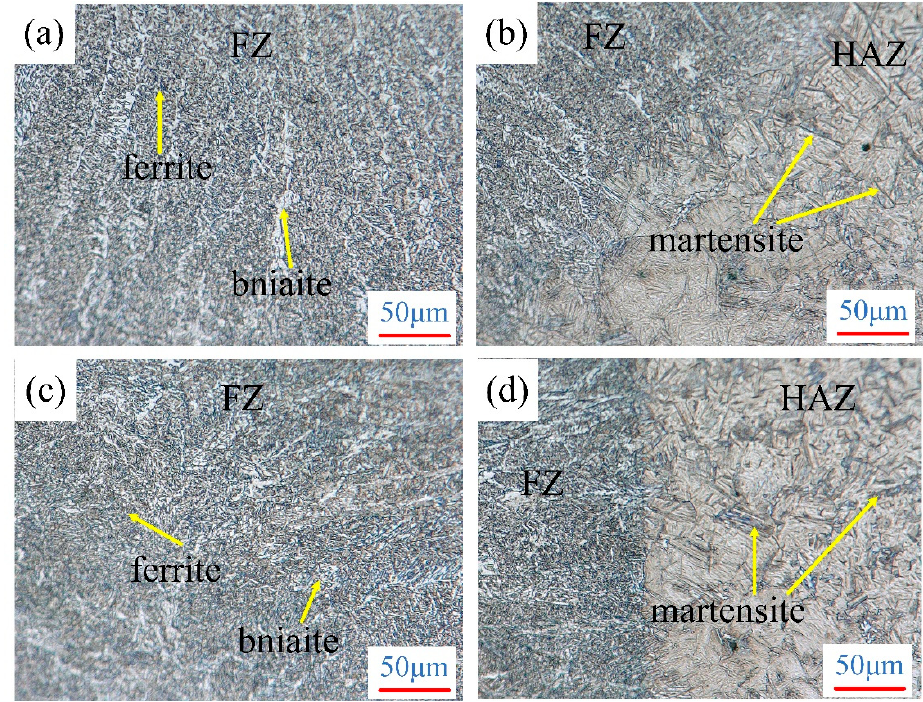
Figure 17. Microstructure of joint with 7.5 kW laser power: ( a ) D1 point, ( b ) D1 point, ( c ) D3 point, ( d ) D4 point.